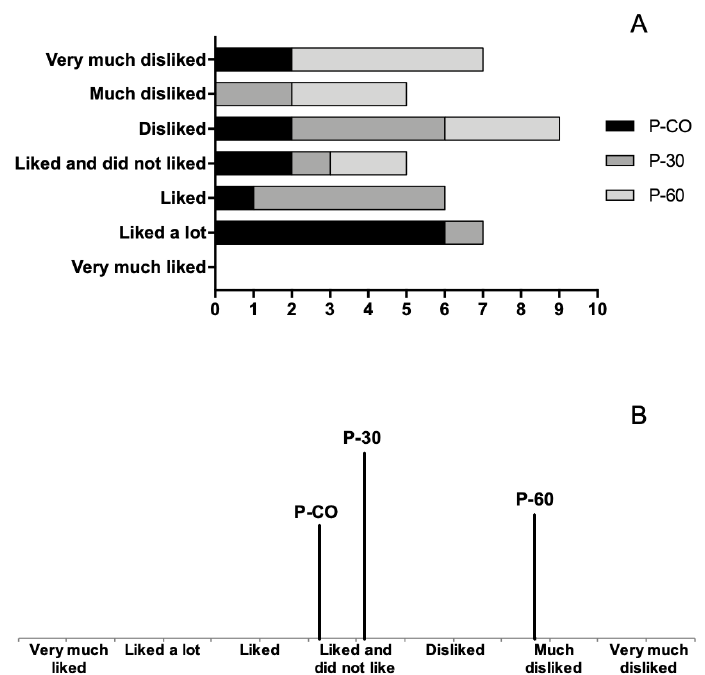
Figure 3. ( A ) Number of preference selections made for every p â t é sample; ( B ) global acceptance